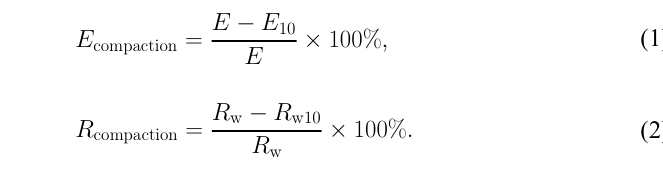
Fig. 5 Correlations between coal rank and values of the elastic moduli